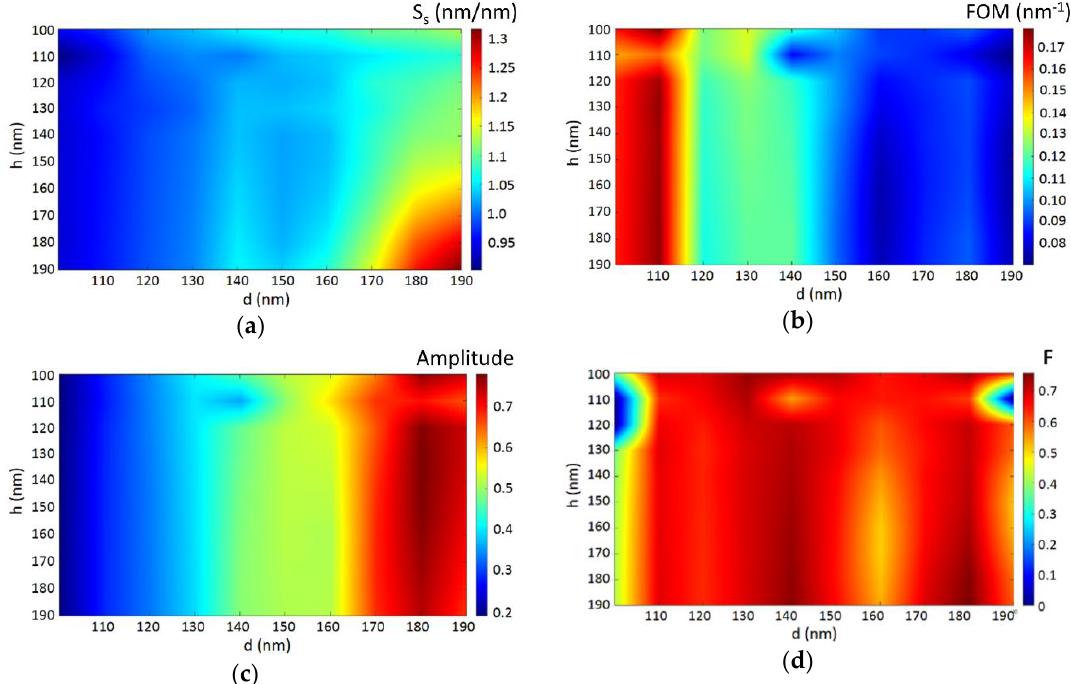
Figure 6. ( a ) Surface sensitivity (S S ) in nm/nm; ( b ) figure of merit (FOM) in nm −1 ; ( c ) reflectance resonance amplitude and ( d ) desirability function (F) for w 1 = 0.3, w 2 = 0.5, and w 3 = 0.3 of the studied Al/polymer 2D plasmonic crystal as a function of the design parameters d and h .